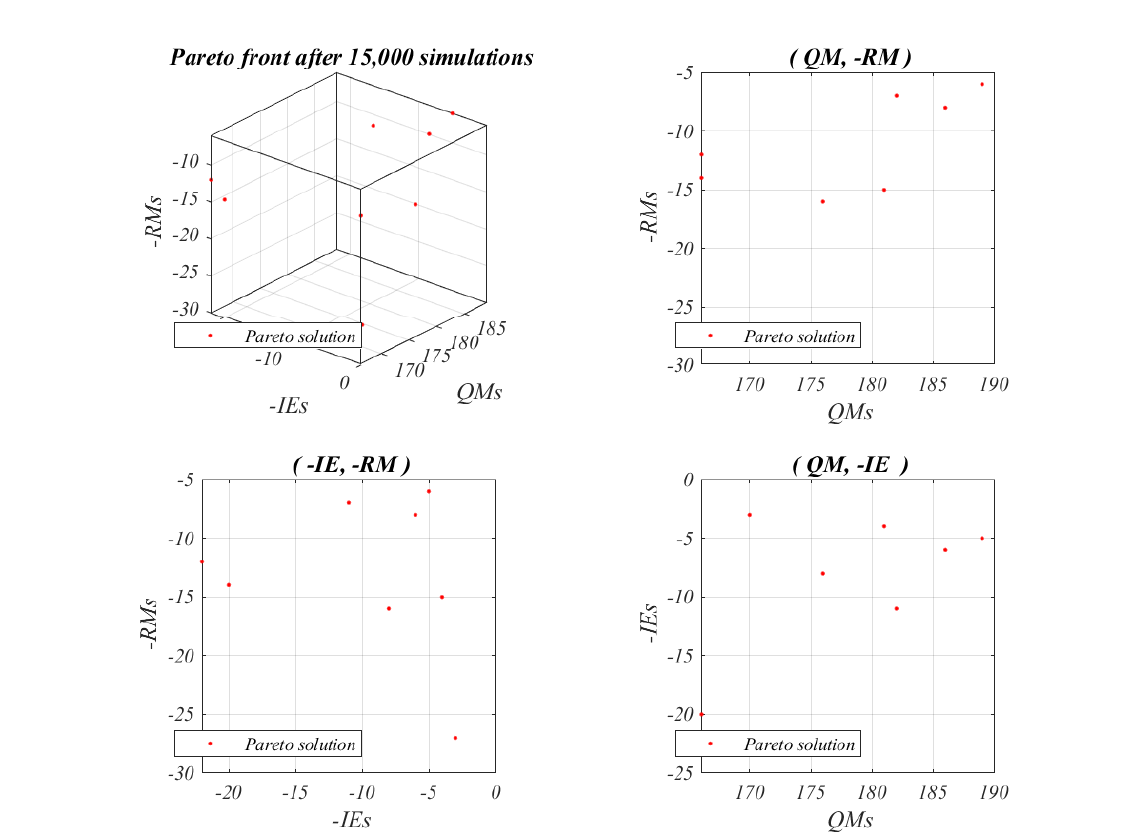
Figure 3. Pareto optimal solutions of multi-objective PSO with some marked designs. Each subfigure emphasizes different angles.